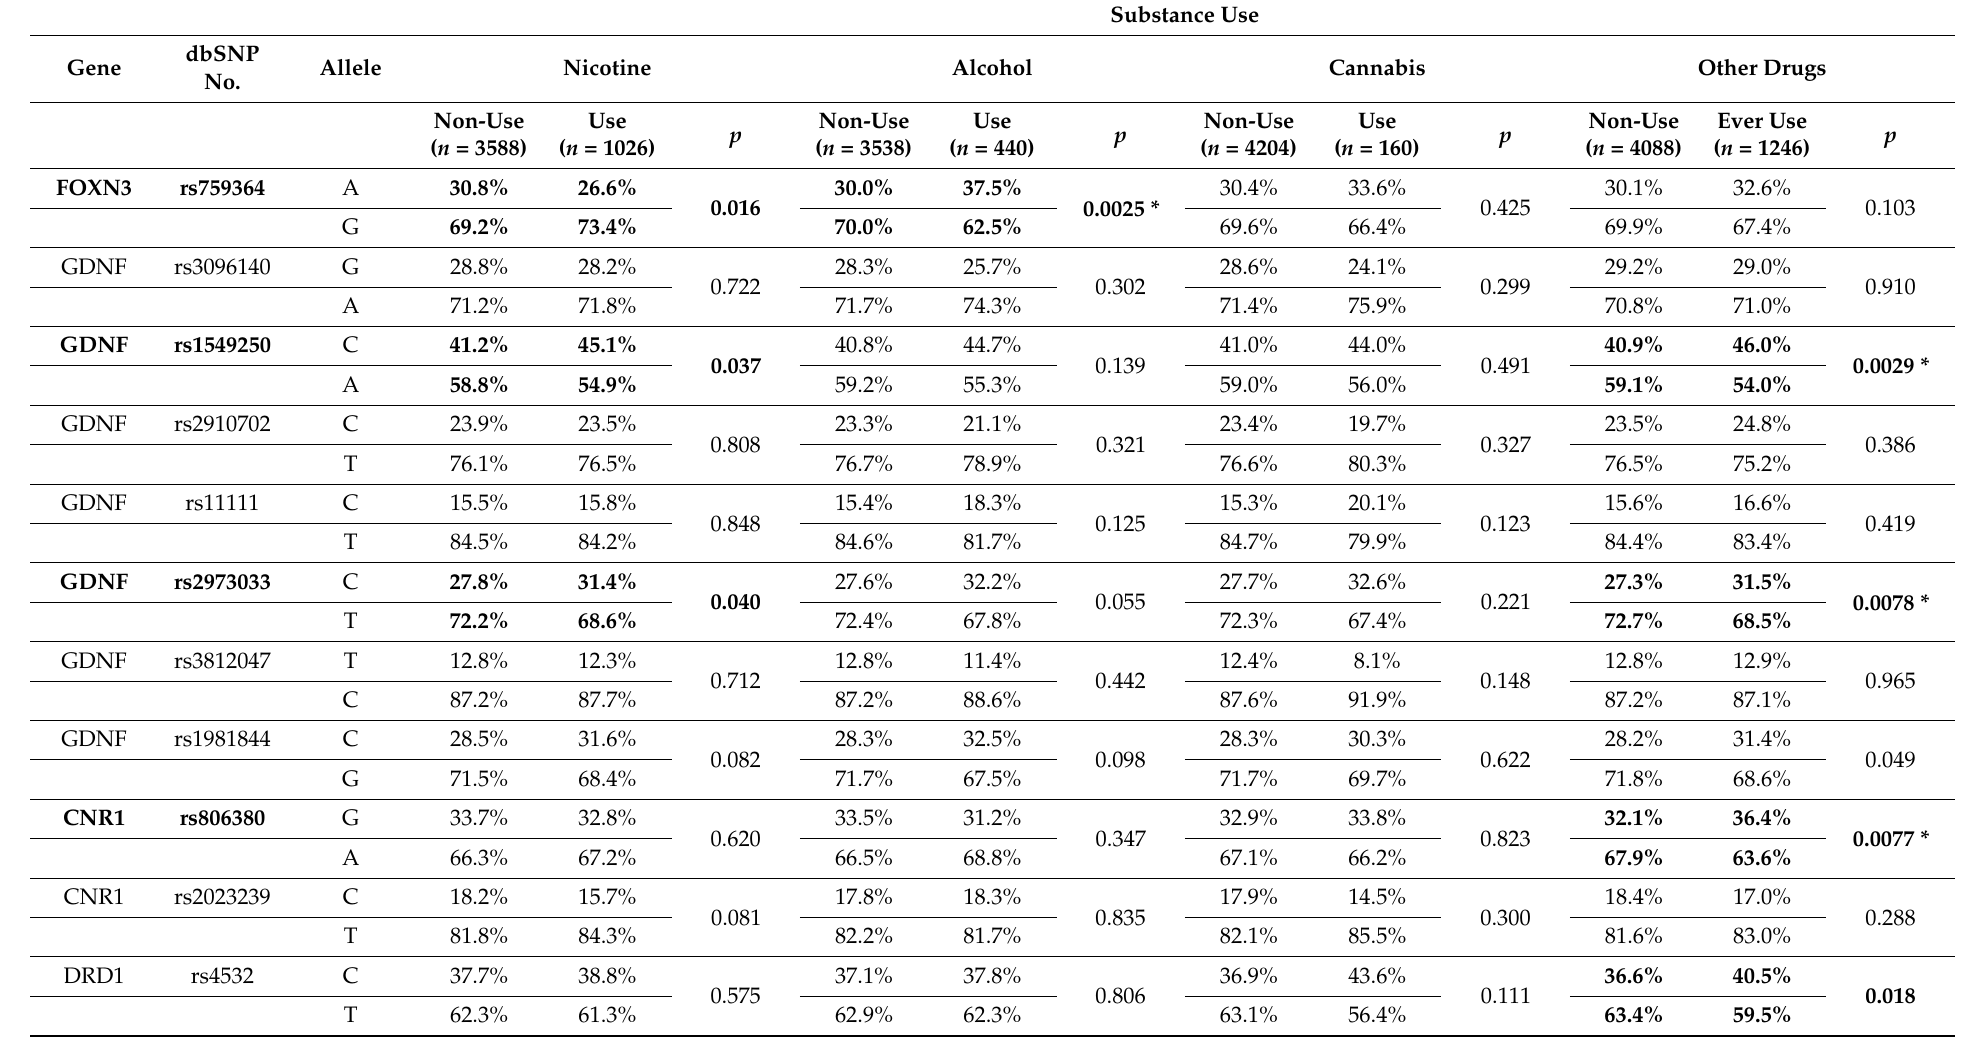
Table 1. Genetic association analysis results regarding addiction candidate genes and potentially addictive substance